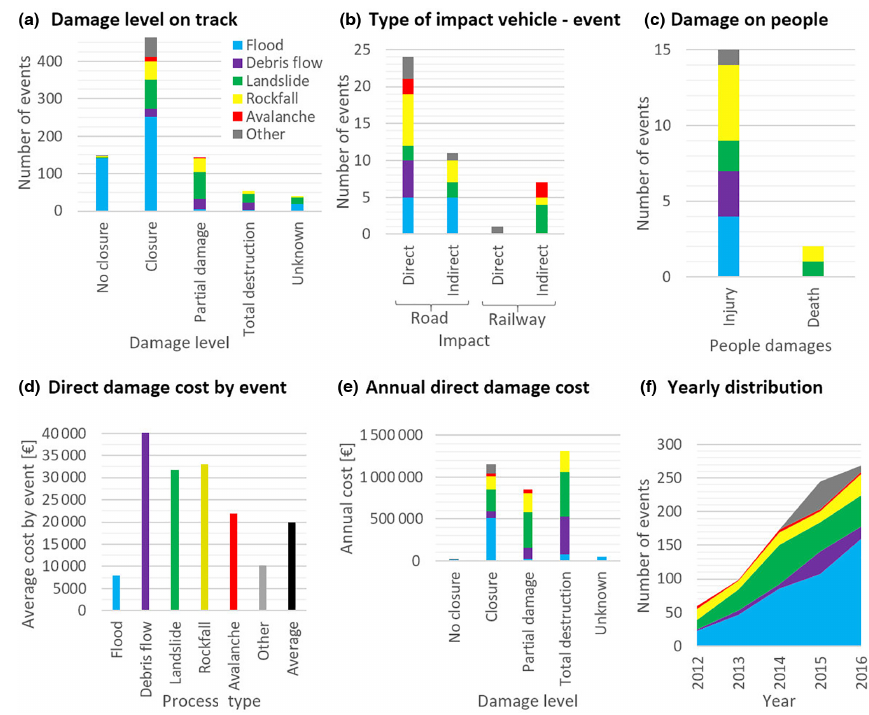
Figure 6. (a) Damage distribution. (b) Distribution of impact types for vehicles on roads or railways and natural hazard events. (c) Distribu- tion of injuries and deaths. (d) Distribution of the average event direct cost. (e) Distribution of the annual direct cost. (f) Annual